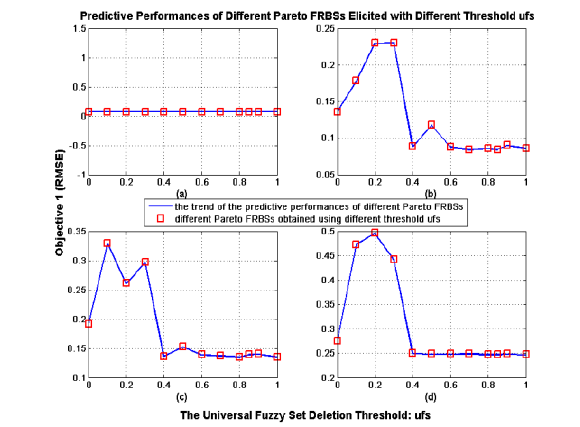
Fig. 15. (a) 5-rule FRBS; (b) 4-rule FRBS; (c) 3-rule FRBS; (d) 2-rule FRBS.